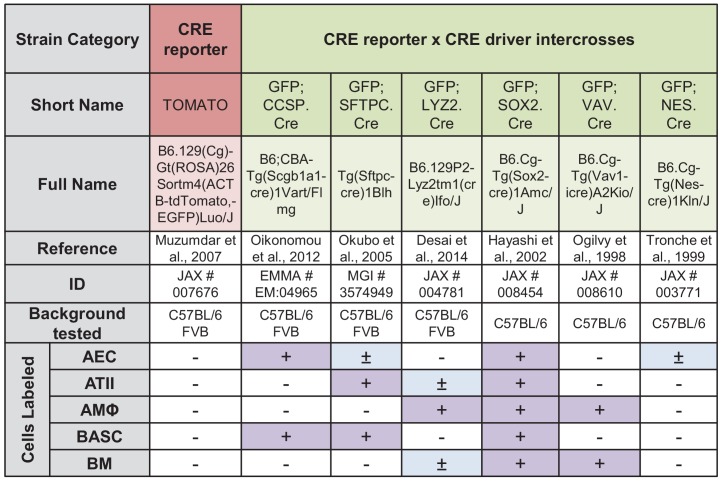
Genetic labeling of pulmonary lineages in eleven mouse strains and intercrosses: summary of results.CRE, causes recombination; TOMATO, tdTomato; GFP, green fluorescent protein; CCSP, Clara cell secretory protein; SFTPC, surfactant protein C; LYZ2, lysozyme 2; SOX2, sex determining region Y (SRY)-box 2; VAV, Vav Guanine Nucleotide Exchange Factor 1; NES, nestin; JAX, Jackson Laboratories; EMMA, European Mutant Mouse Archive; MGI, Mouse Genome Informatics; AEC, airway epithelial cells; BASC, bronchoalveolar stem cells; ATII, alveolar type II cells or type II pneumocytes; AMΦ, alveolar macrophages; ΒM, bone marrow (myeloid) cells. Symbols indicate: - (white), no genetic labeling; + (magenta), complete genetic labeling; ± (blue), partial genetic labeling.